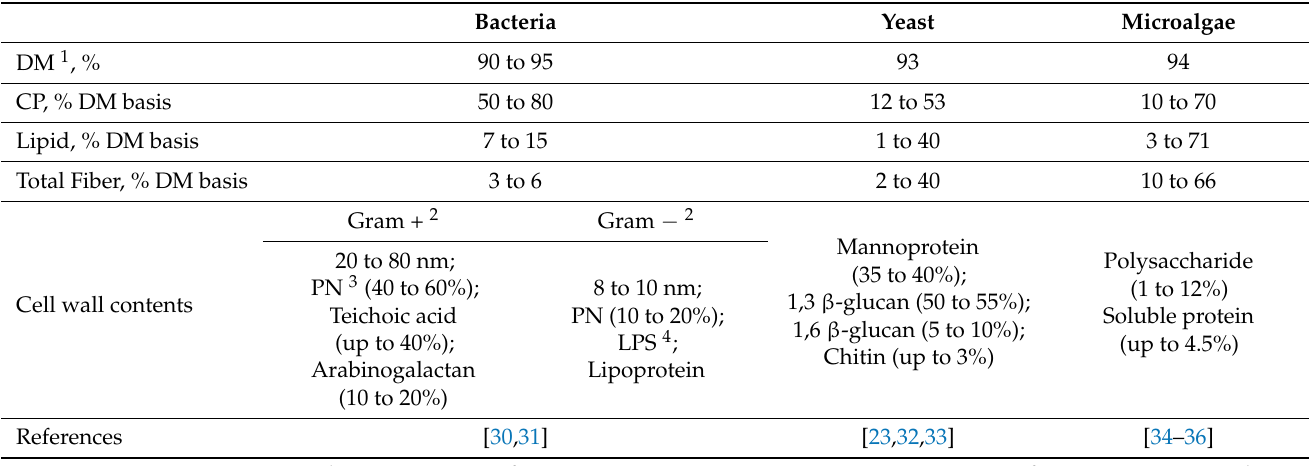
Table 1. Characteristics and nutrient content of bacteria, yeasts, and microalgae.